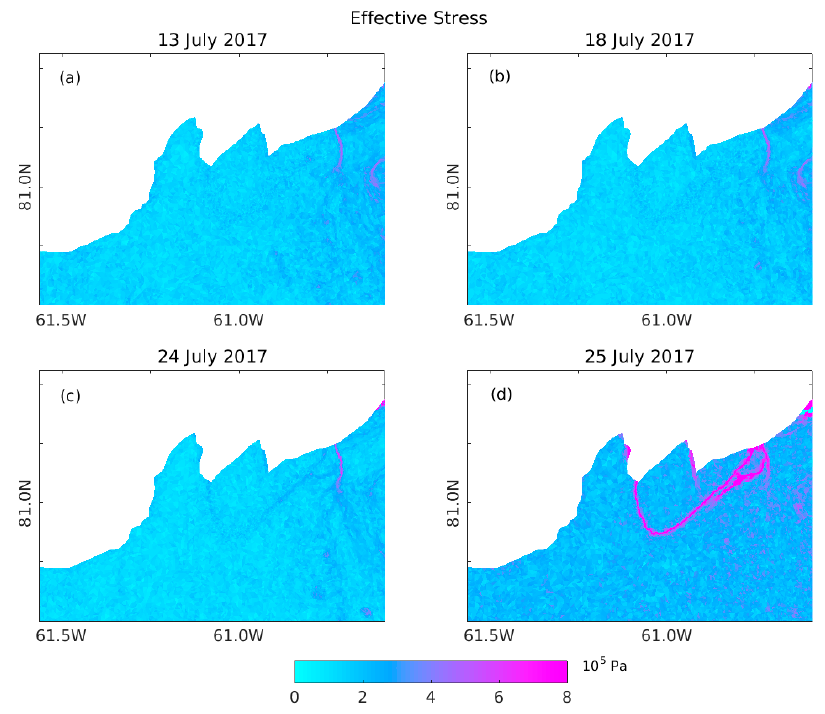
Figure 6. The effective stress distribution evolution for the Petermann Glacier ice tongue in four stages in July of 2017, prior to the calving day. ( a – d ) respectively represent mean effective stress fields from the corresponding periods.